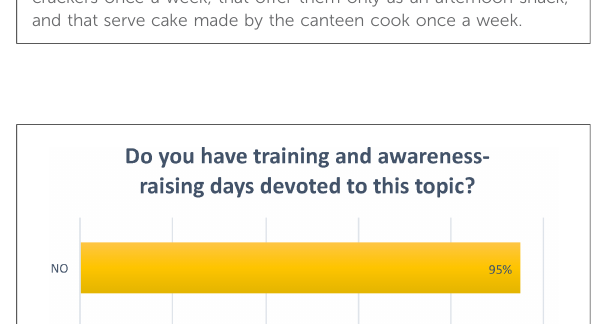
FIGURE 8 If oral hygiene routines are followed, when in the day? In 25% of the nurseries oral hygiene routines are followed after every meal; In 65% of the nurseries only after lunch; In 10% no oral hygiene routines are followed.